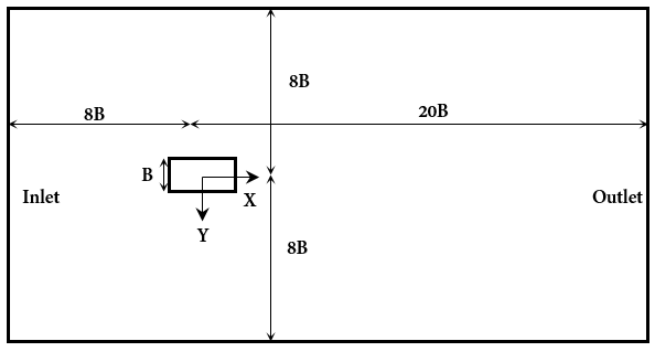
Figure 5. 2D view of the domain (XY-plane) with the inlet and outlet boundaries.